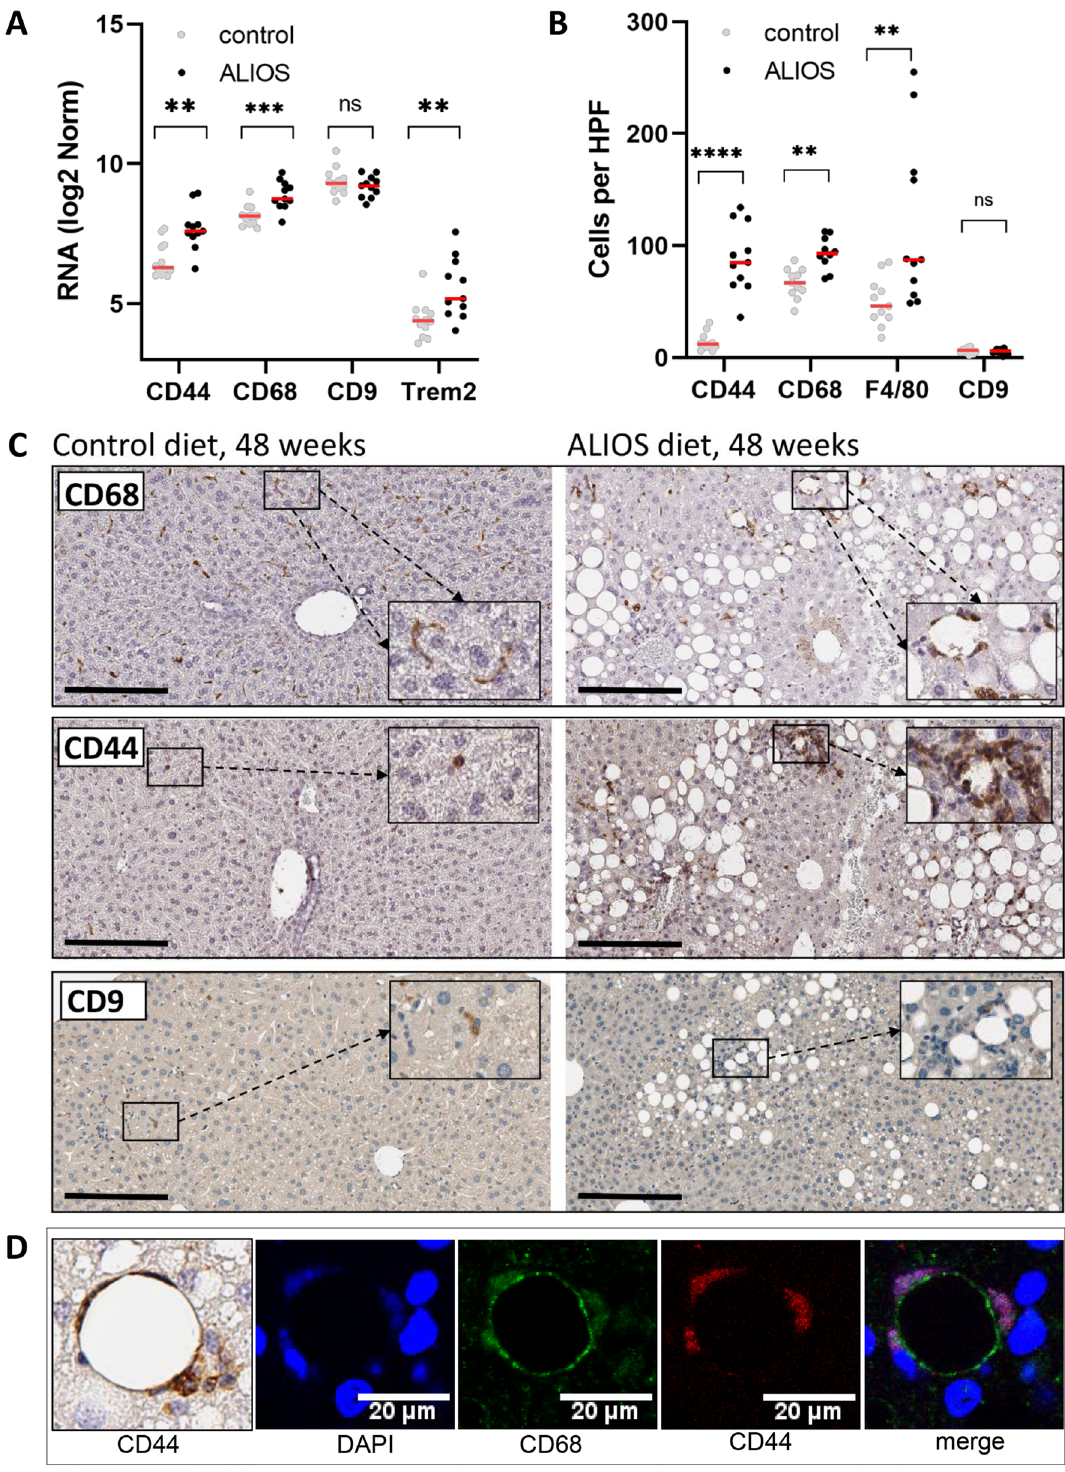
Figure 7. Elevations in CD44 + macrophages in aged, fatty non-tumour liver. Messenger RNA levels in RNA- Seq studies of whole liver tissues at 48 weeks confirmed elevations in CD44, CD68 and Trem2 in ALIOS fed animals, while CD9—present at relatively high levels in control and 48 week ALIOS fed mice—was unchanged ( A ). Counts of positive protein expressing cells detected by IHC followed a similar pattern, although Trem2— with the lowest transcript levels—was not detected in FFPE tissues (not shown). The most striking change was for CD44 + cells, which were scant in controls but prominent in ALIOS fed mice—notably in lipogranulomas ( C ), with dual staining confirming co-expression of CD68 and CD44 ( D ). Counts are shown as numbers per high power field (HPF). ns—not significant; * < 0.05;**p < 0.01; ***p < 0.001; ****p < 0.0001 Mann–Whitney